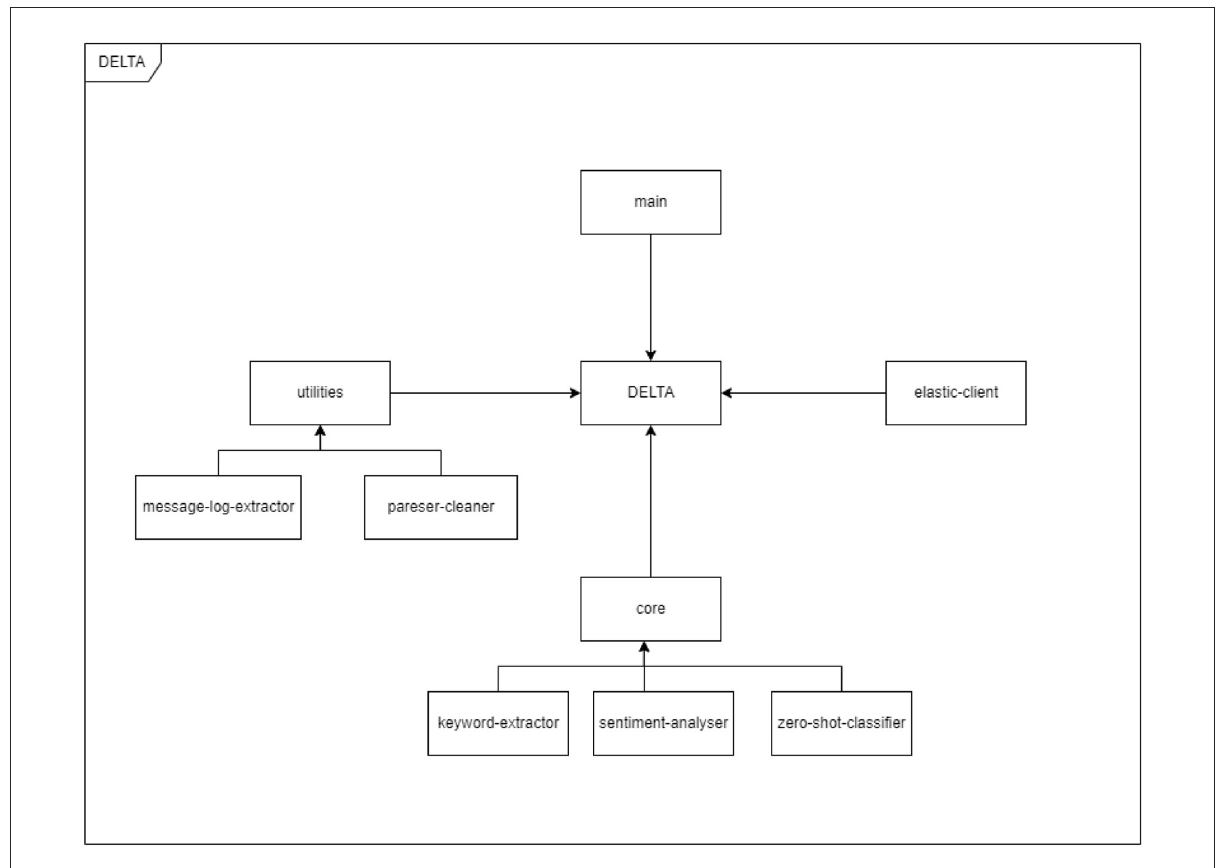
FIGURE3 Structure of the